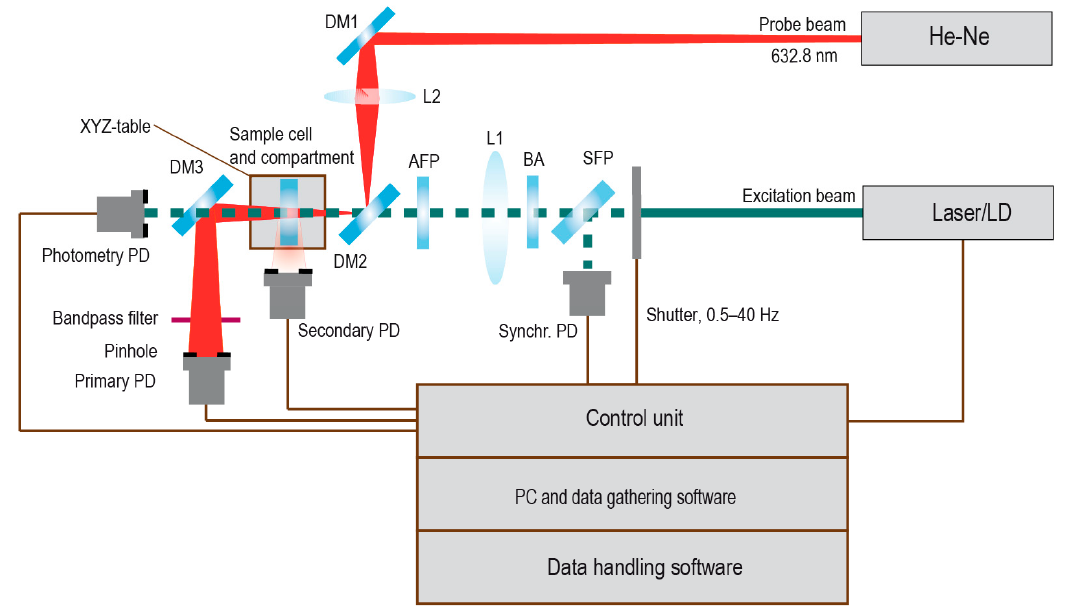
Figure 1. The schematic diagram of the thermal-lens setups (scale of distances between optical elements is not shown).